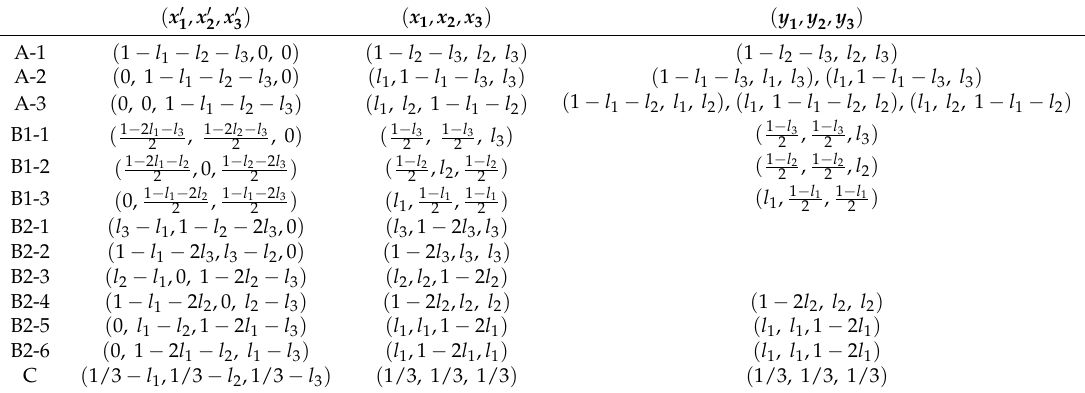
) , ( x , x (cid:48) , x (cid:48) 1 , x 2 , x 3 2 3 1